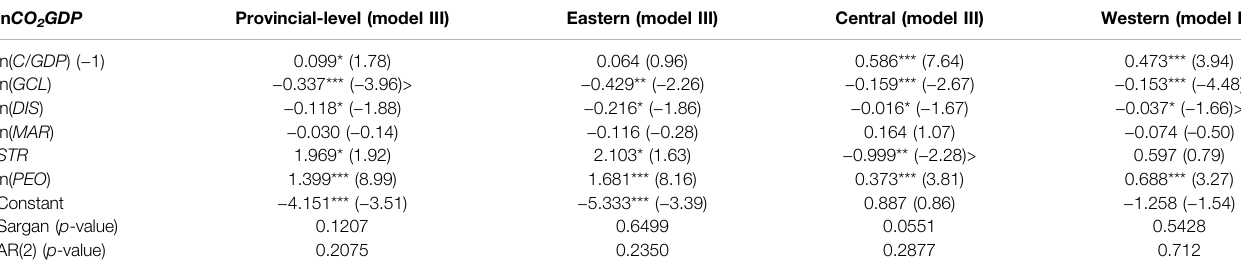
TABLE 4 | Results of system GMM on the impact of green credit and disruptive innovation on carbon emission.